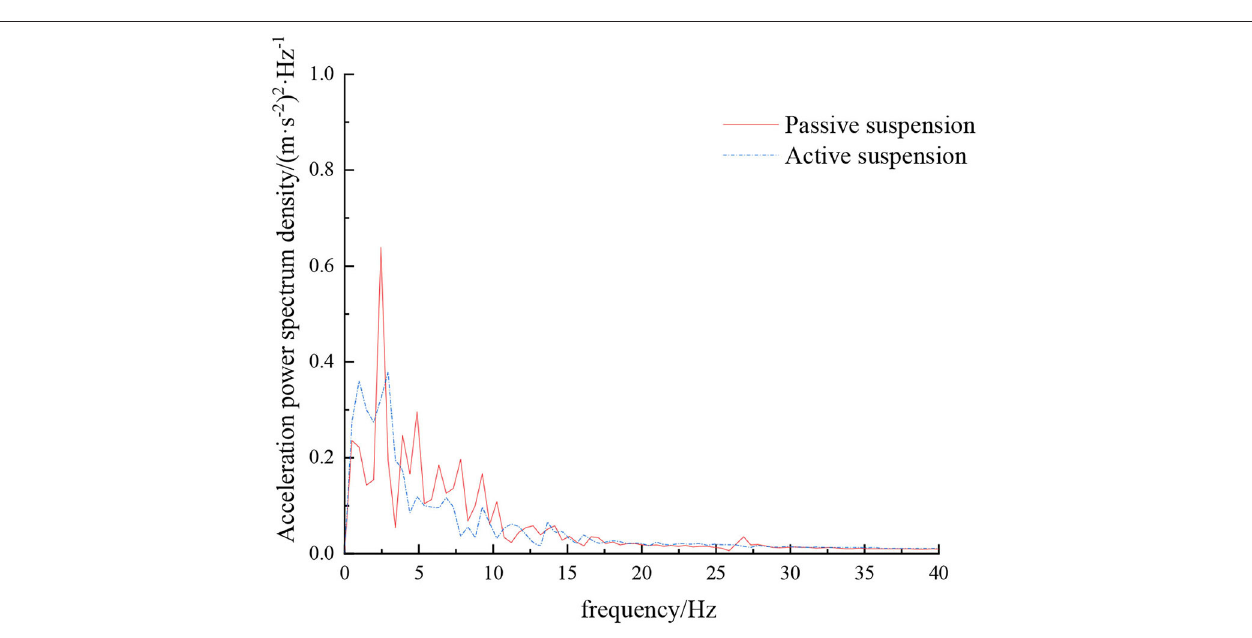
FIGURE 9 | Frequency domain response curve when driving at 5km/h on field